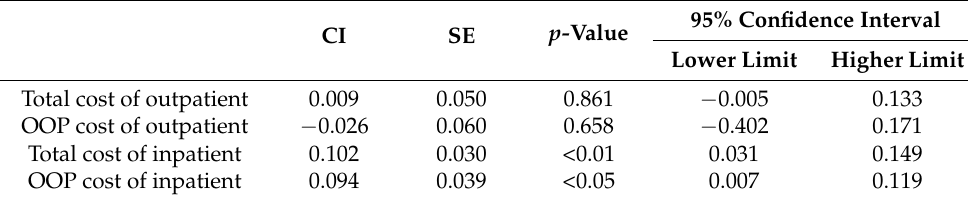
Table 7. CIs of two-week outpatient costs and inpatient costs among rural migrant workers with